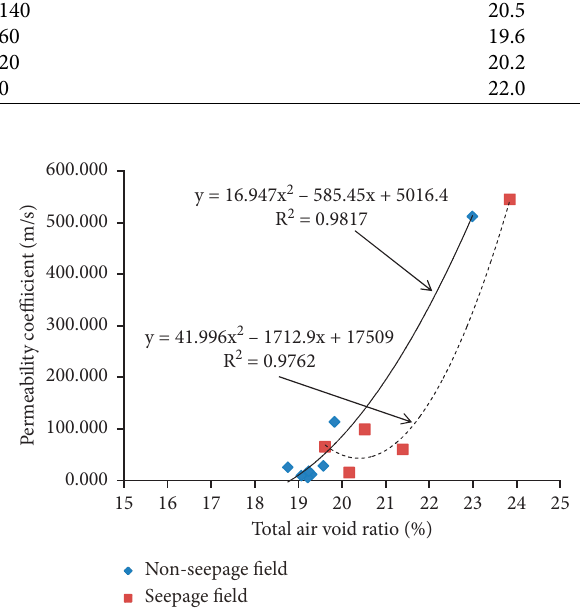
Figure 16: Relationship between total void ratio and non-Darcy flow permeability coefficient.